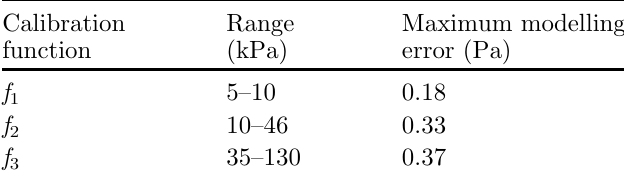
Table 2. Rescaling coef fi cient of the CDG10k and drift in the offset of the